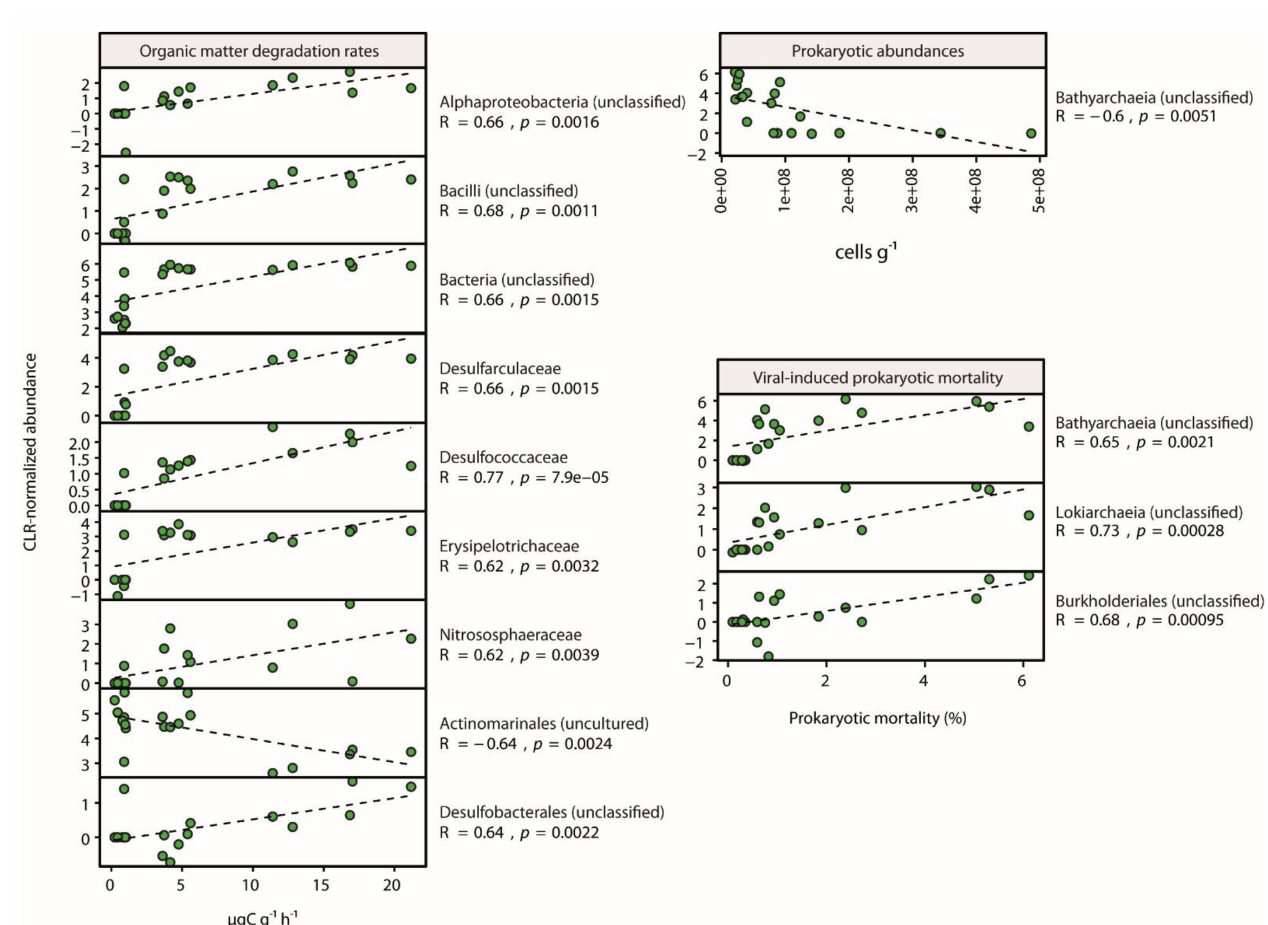
Figure 6. Linear regression analysis on CLR-normalized abundances of differentially abundant prokaryotic taxa at the family level, only considering taxa with R > 0.6 and p -values <